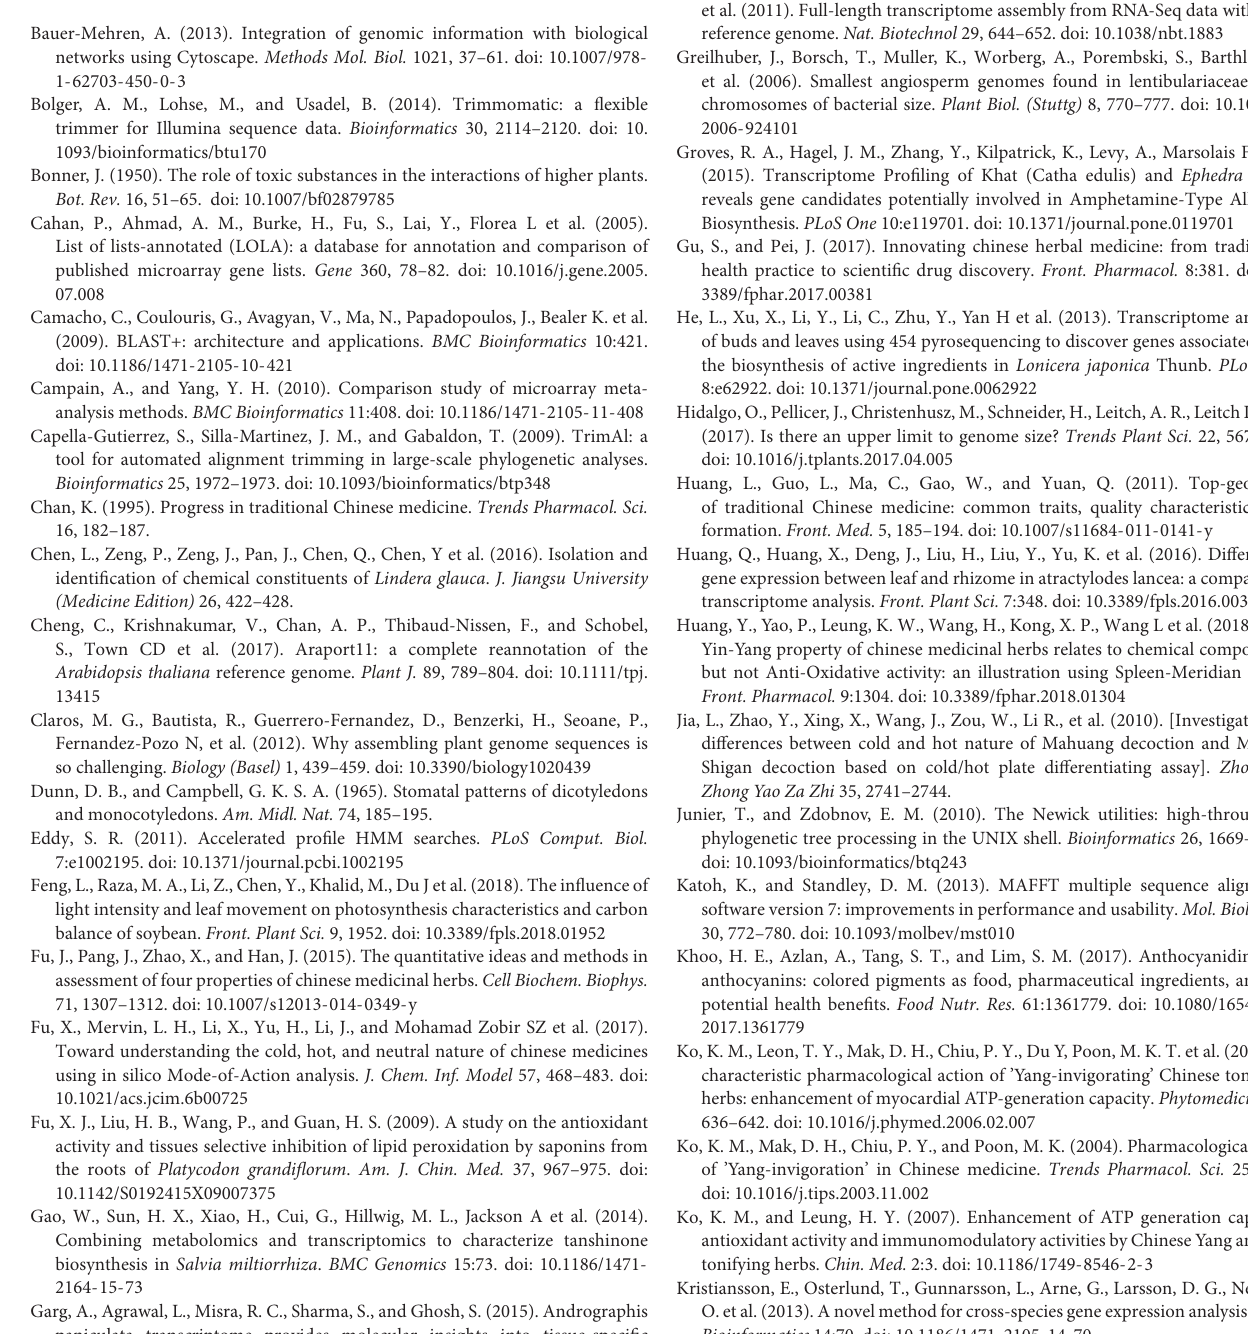
DATA S4 | HMs property-specific genes and enriched categories. DATA S5 | HMs property-specific compounds and the metabolic